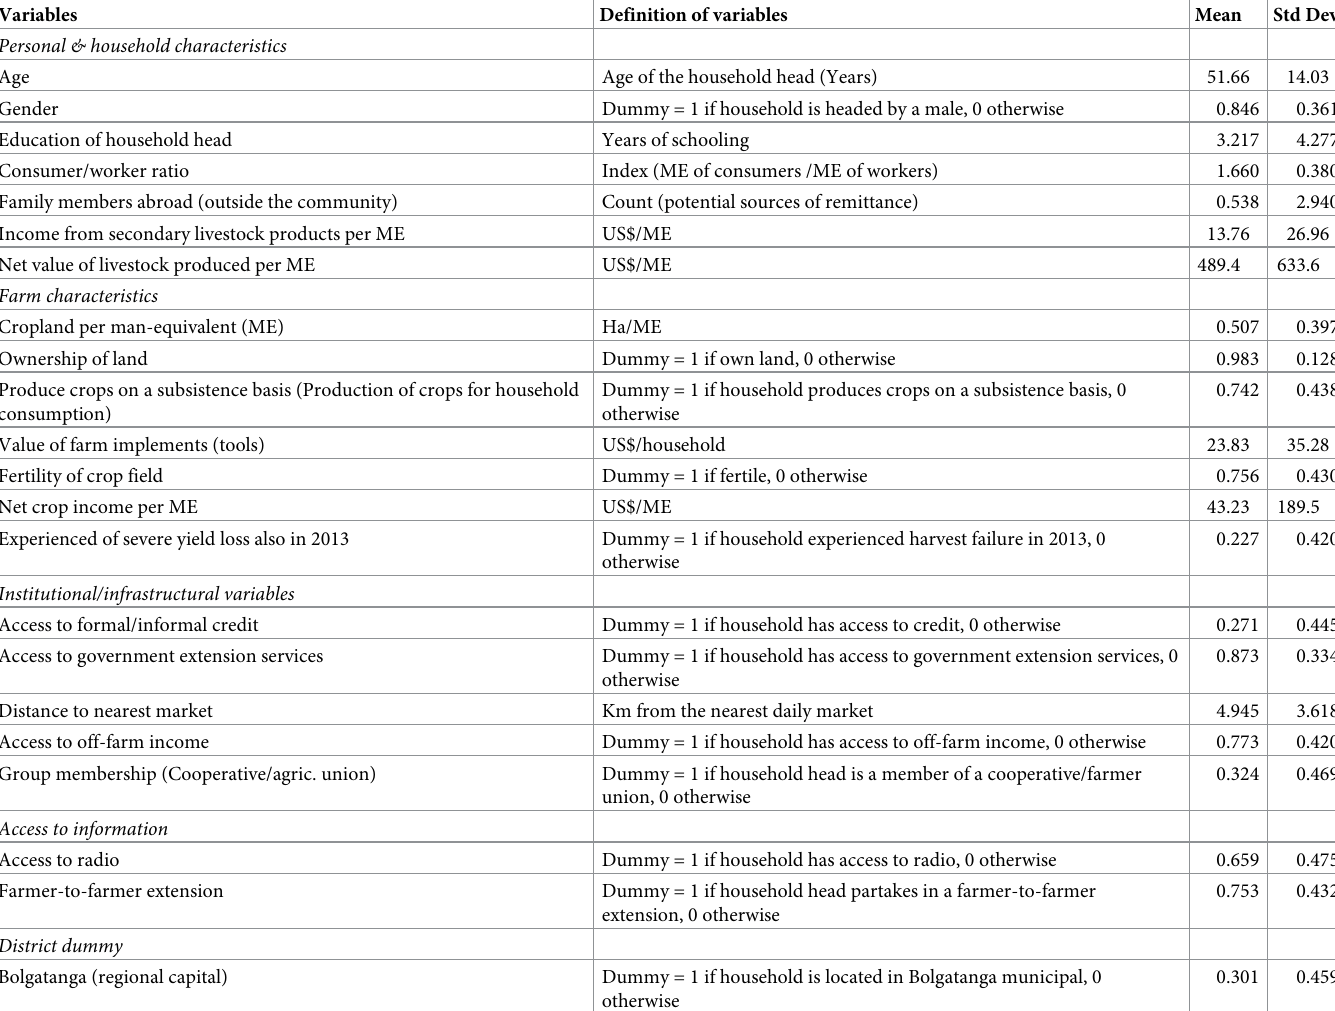
Table 1. Descriptive statistics of variables used in the regression